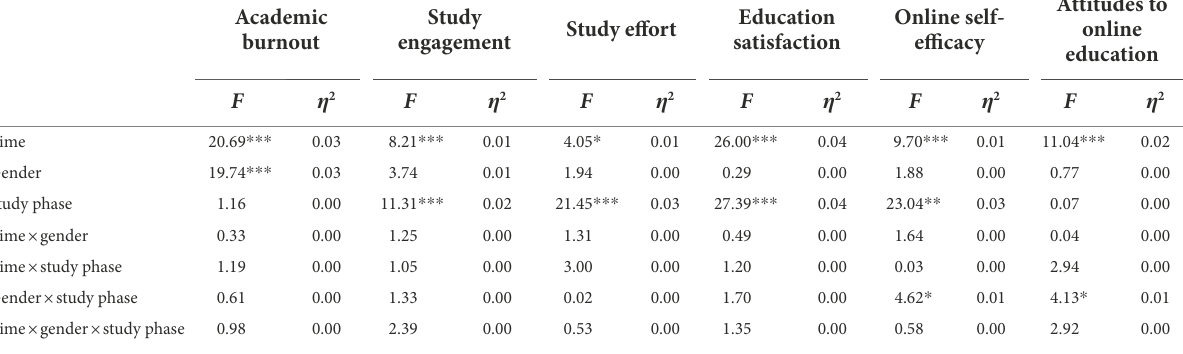
TABLE 2 Results of the six 3 (time: t1 vs. t2 vs. t3) × 2 (gender: male vs. female) × 2 (study phase: bachelor vs. master) mixed design analyses of